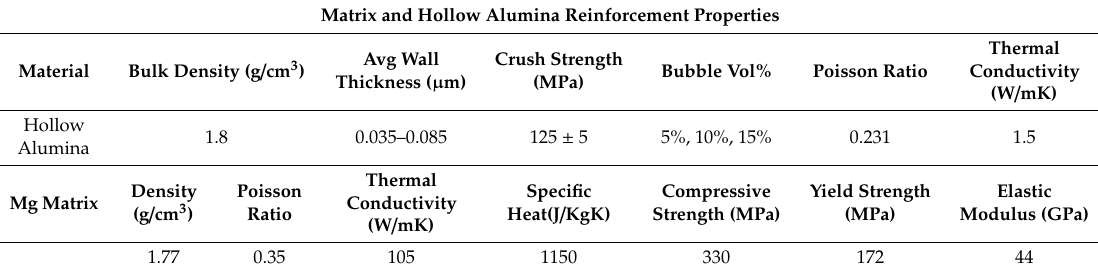
Table 2. Properties of matrix and